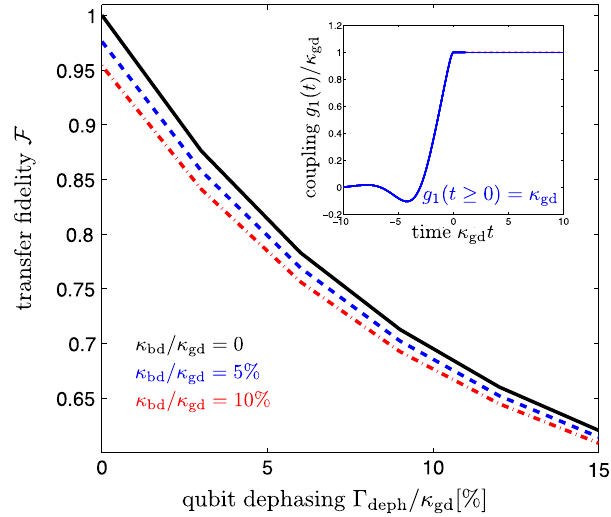
FIG. 16. Quantum state transfer protocol in the presence of Markovian noise. State transfer fidelity F for a coherent super- ffiffiffi p 2 position j ψ i ¼ ðj 0 i − j 1 iÞ = as a function of the qubit ’ s dephasing rate Γ for different values of intrinsic phonon deph 0 (black solid line), κ 5% (blue dashed = κ = κ losses κ bd gd ¼ bd gd ¼ 10% (red dash-dotted line). Inset: Pulse = κ line), and κ bd gd ¼ shape g 1 ð t Þ for first